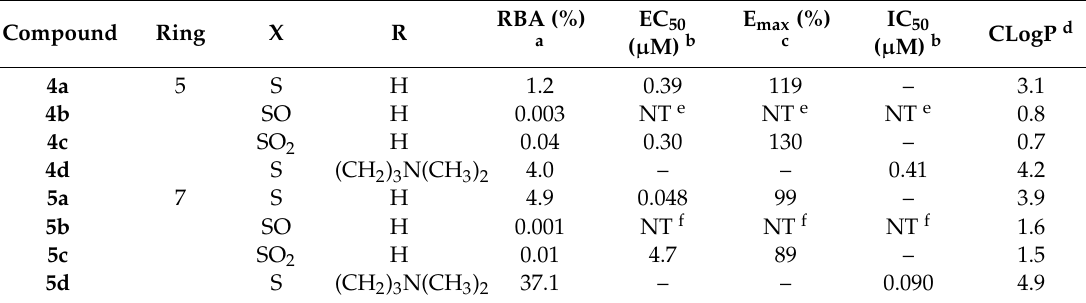
Table 1. Biological profiles of compounds 4a – 4d and 5a – 5d